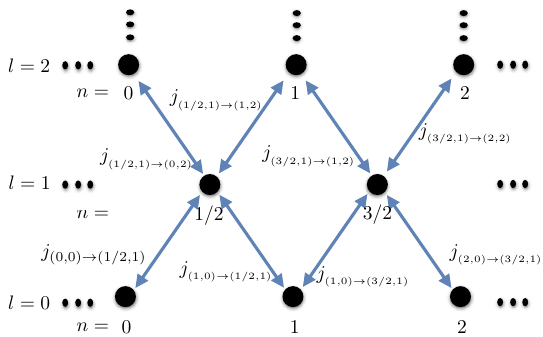
n (cid:48) , l (cid:48) ) → ( n , l )